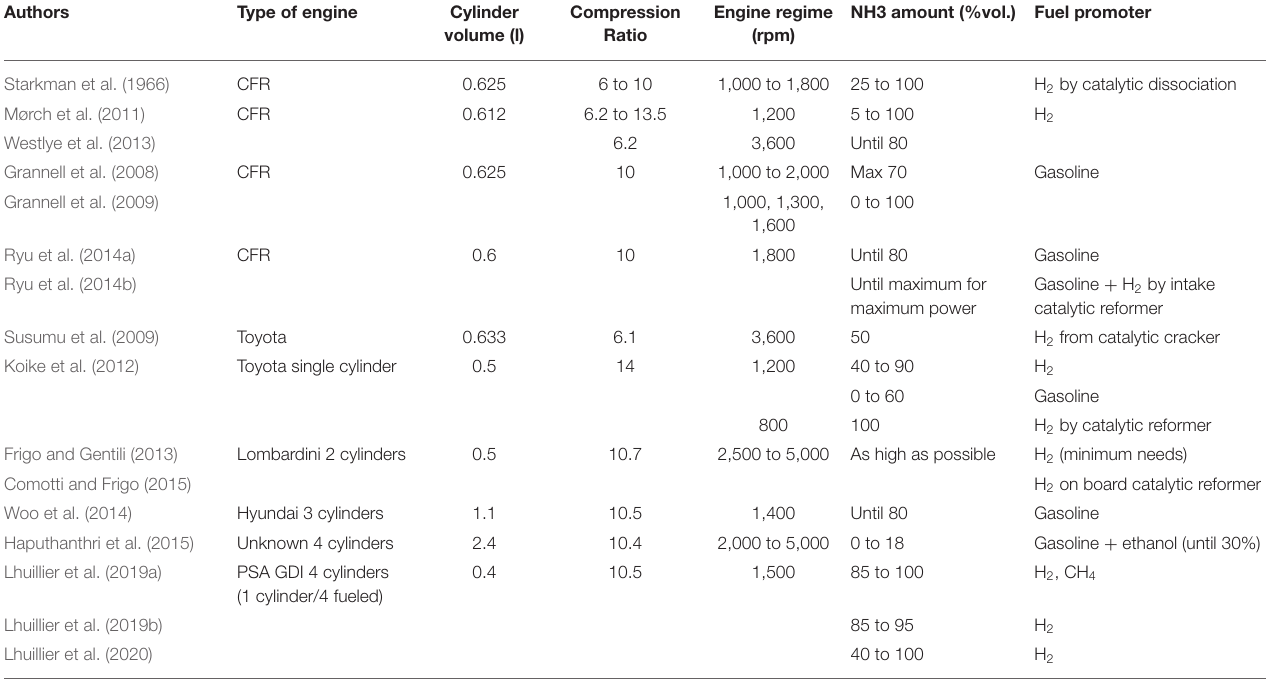
TABLE 1 | Main studies and literature results on the use of ammonia in SI engines.